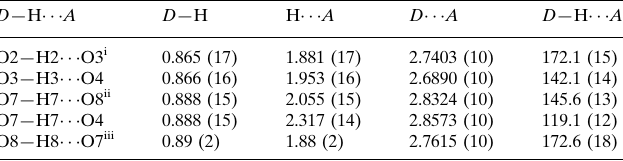
Hydrogen-bond geometry (A˚ , (cid:2)